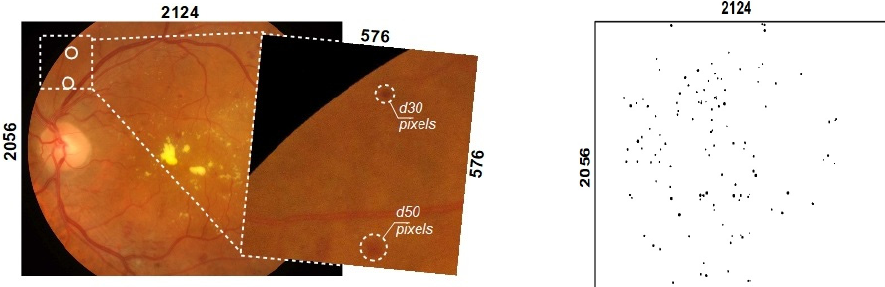
Figure 2. An example of a color fundus image ( left ) and annotated image represented as an MA segmentation map ( right ).